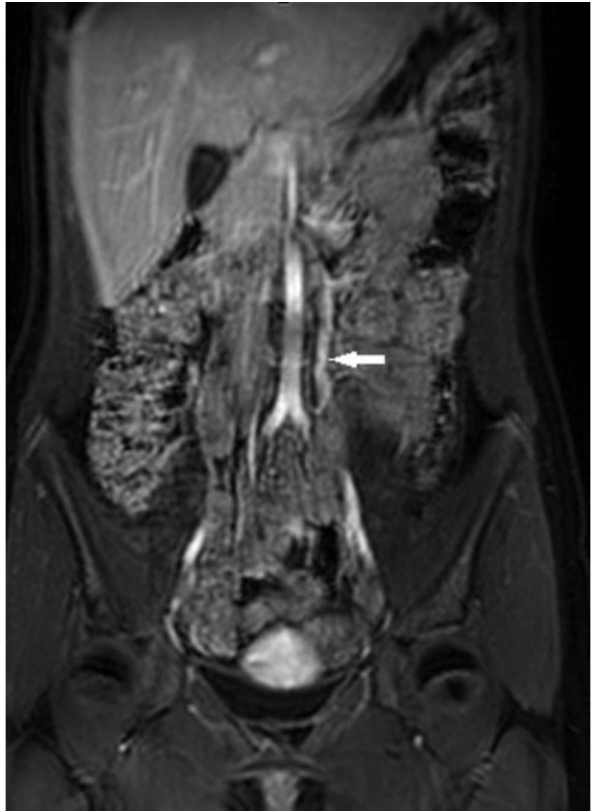
Fig. 2 Magnetic resonance imaging showing a dilated left ovarian vein (white arrow) with a caliber of 8mm and a grade II re fl ux, draining into the retroaortic component of the left renal